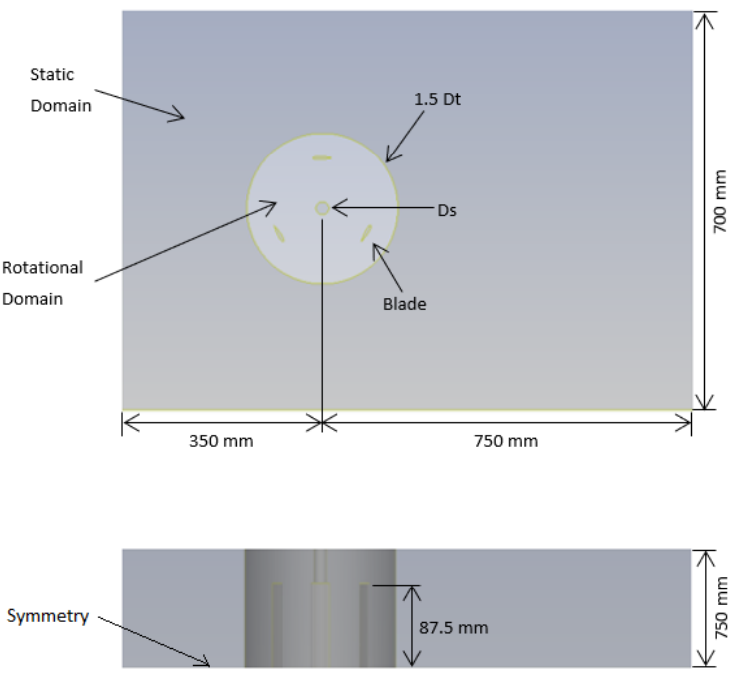
Table 1. Parameters for different mesh sizes close to the blades. Figure 1. Computational domain and turbine geometry. Figure 1. Computational domain and turbine geometry.